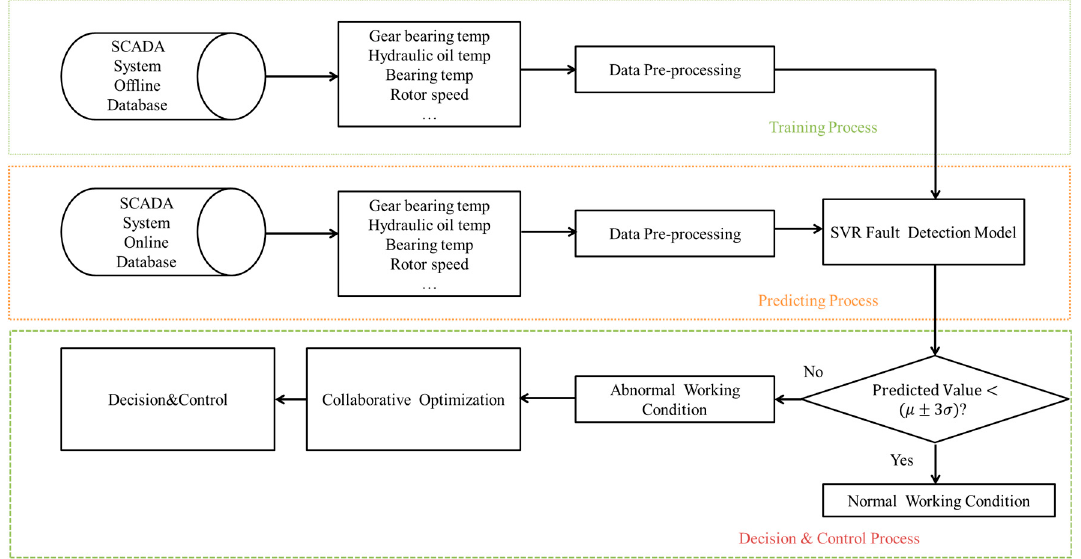
Figure 1. Fault detection underpinned by support vector regression (SVR).